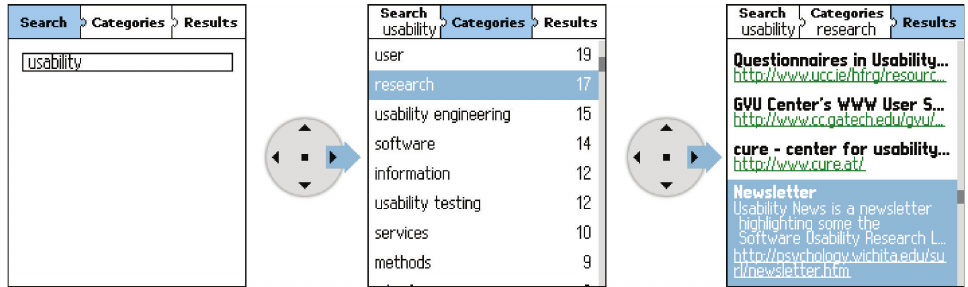
Figure 1: Mobile Findex search user interface, with the query view (left), category view (middle), and result list view